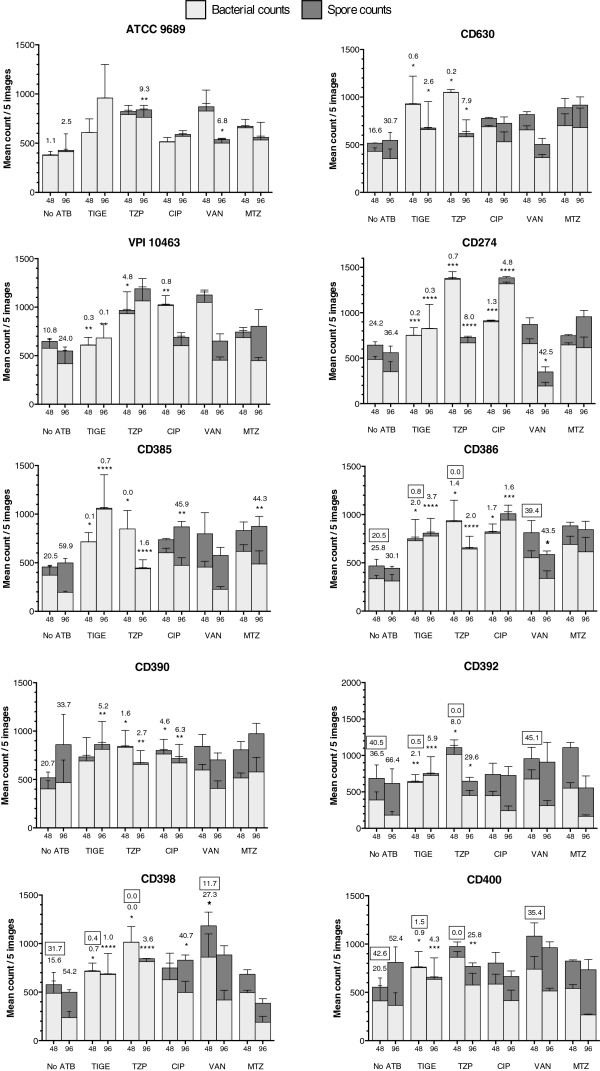
Stacked bar graph showing the number of vegetative cells and spores in colonies grown for 48 h and 96 h on TY agar without antibiotics (No ATB) or with 0.5x MIC of TIGE, TZP, CIP, VAN, or MTZ. The values of spore counts (dark grey bars) are stacked on top of the vegetative cell counts (lower light grey bars). The percentage of spores formed in the presence or absence of antibiotics was also calculated for each condition and compared by one-way ANOVA. When the percentage of spores was significantly lower compared to the control. For simplicity, only the % spores for the controls and the significantly different conditions are indicated above the corresponding bars. Boxed values above some of the bars represent the % spores calculated using a spore recovery assay on agar plate after ethanol shock. Values represent means ± standard error of the mean of 3 independent experiments (mean of 5 microscopy images/experiment). Statistical significance: * = p < 0.05, ** = p < 0.01, *** = p < 0.001 and **** = p < 0.0001.